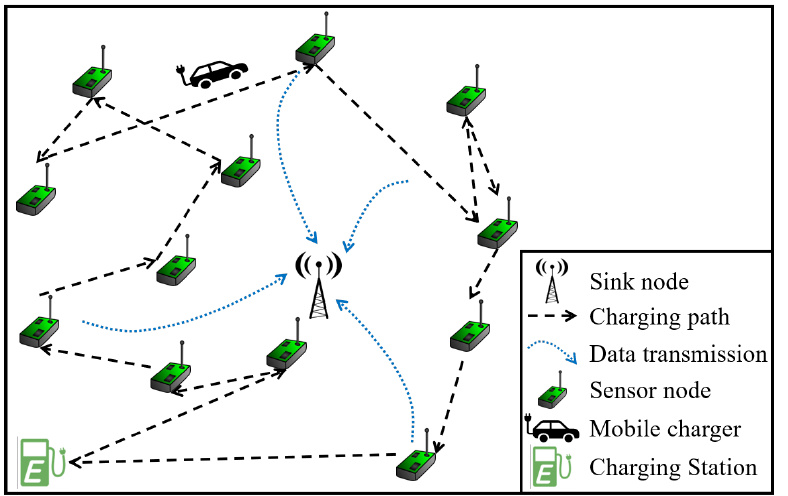
Figure 1. Schematic diagram of the mobile charging WRSN